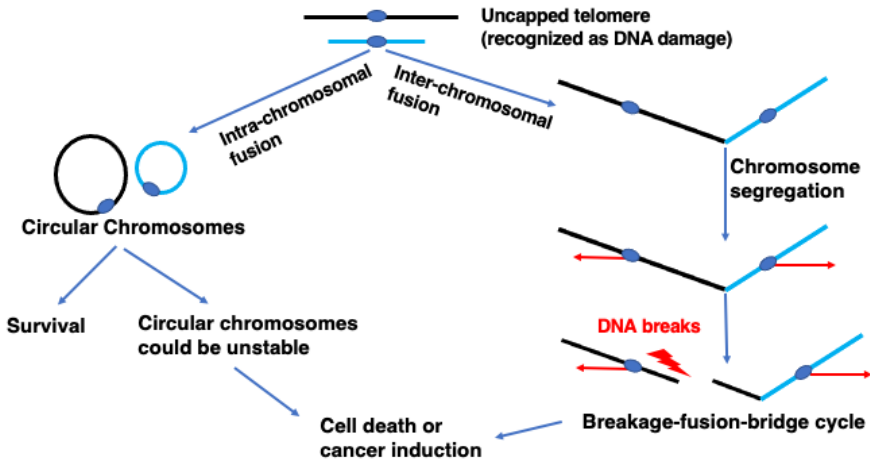
Figure 1. Uncapping of telomeres leads to chromosome abnormalities. Telomere uncapping results in breakage–fusion–bridge (BFB) cycles or chromosome circularization. Inter-chromosomal fusion generates dicentric chromosomes. Segregation of the two centromeres towards opposite poles creates chromatin bridges, which will result in DSB. The DSB ends will be fused, generating dicentric chromosomes. This breakage–fusion–bridge (BFB) cycle results in translocations and aneuploid nuclei, which can drive cancer. Intra-chromosomal fusion generates circular chromosomes, which can be unstable, and result in chromosome breaks and/or rearrangement that could induce cancer.